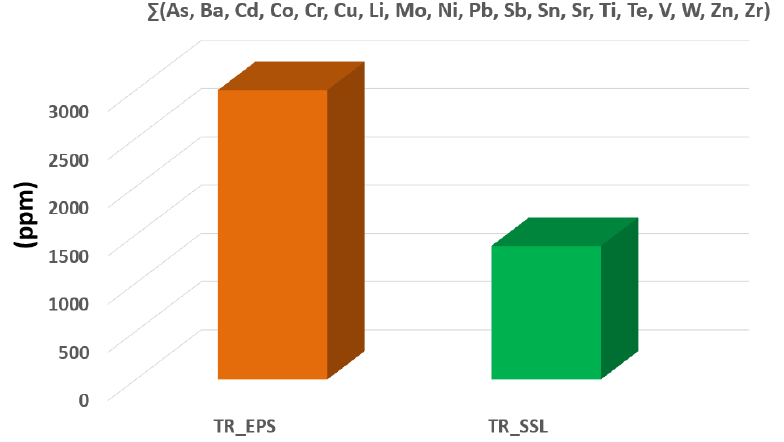
Figure 6. Total trace elements concentration (ppm) in the investigated samples. TR_EPS = tremolite asbestos from Episcopia; TR_SSL = tremolite asbestos from San Severino Lucano. Table 3. Trace elements (ppm) in the analyzed tremolite asbestos from Episcopia (TR_EPS), San Severino (TR_SSL), and tremolite asbestos from GMRU (TR_GMRU) and Val d’Ala (TR_VLA) studied by Bloise et al. [15,16] showed for comparison. * Indicative baseline data for some trace elements in normal human lung tissues [29].